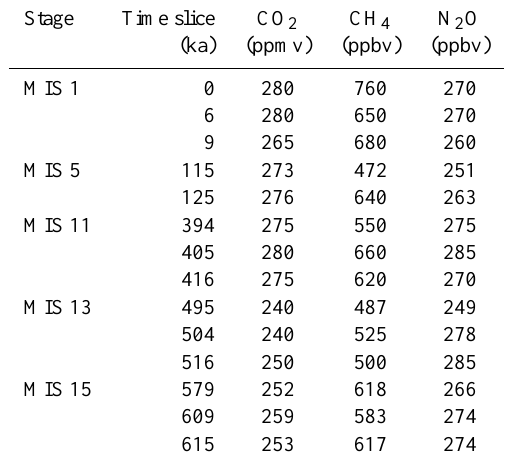
Table 1. Atmospheric GHG concentrations used in the interglacial